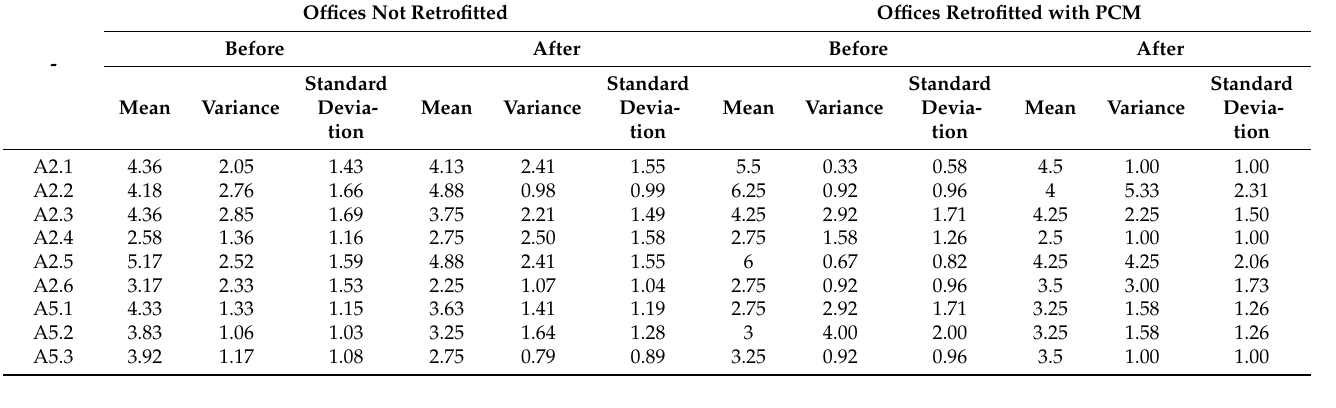
Table 9. IEQ descriptive statistics for offices with PCM and control rooms in the JL Building.